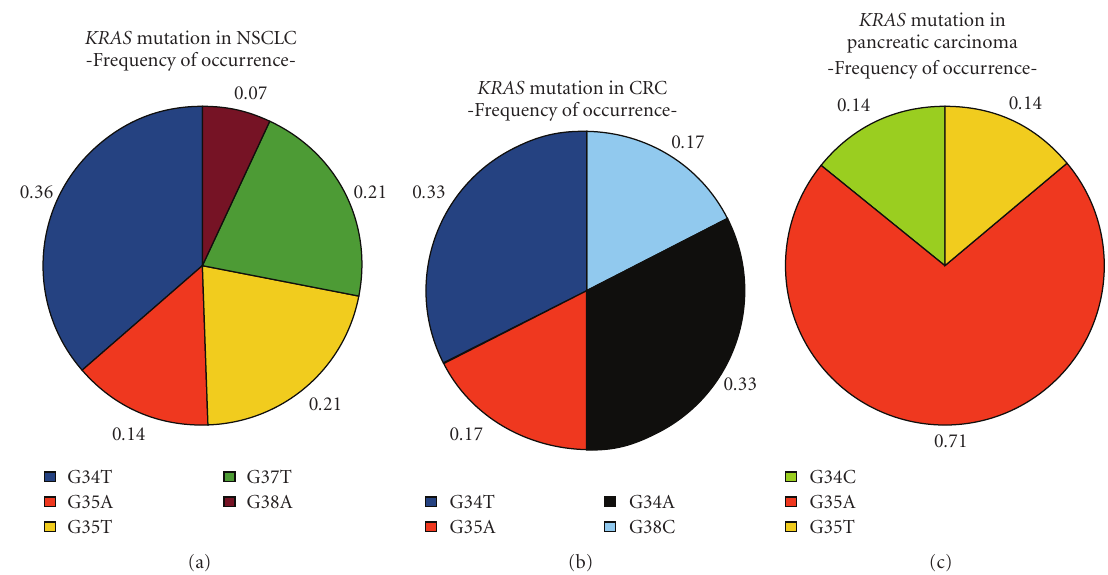
Figure 2: Delaminating of KRAS genotype of di ff erent tissue specimen. This picture shows the percentage of mutation types found in the particular kind of cancer specimens. The legend under the picture explains the colours used for the di ff erent